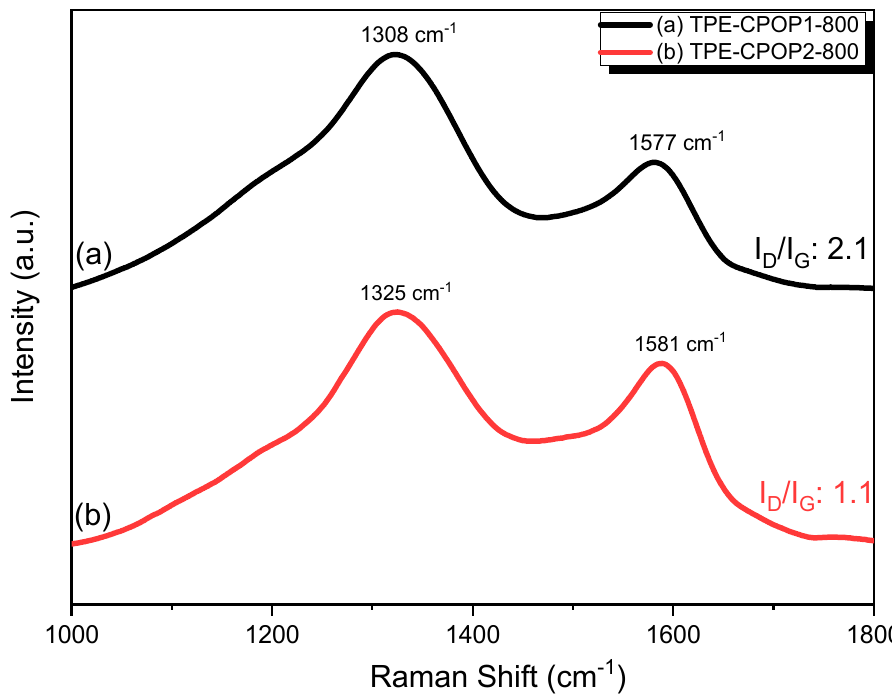
Figure 8. Raman profile of ( a ) TPE-CPOP1-800 and ( b ) TPE-CPOP2-800.